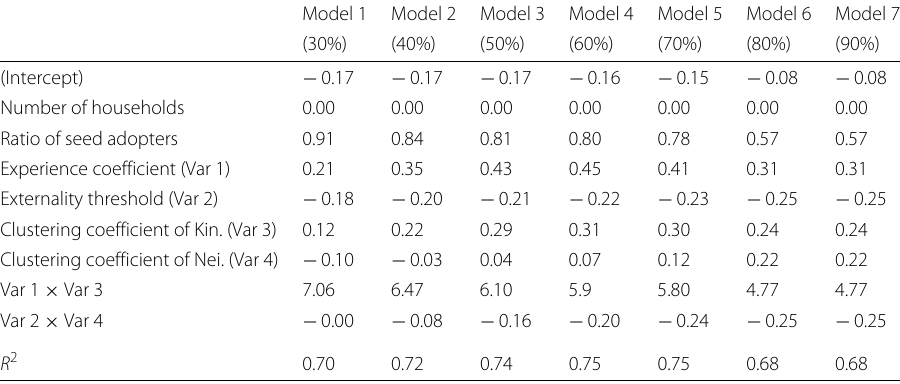
Table 5 Regressions of adoption speed on clustering coefficient (positive externality